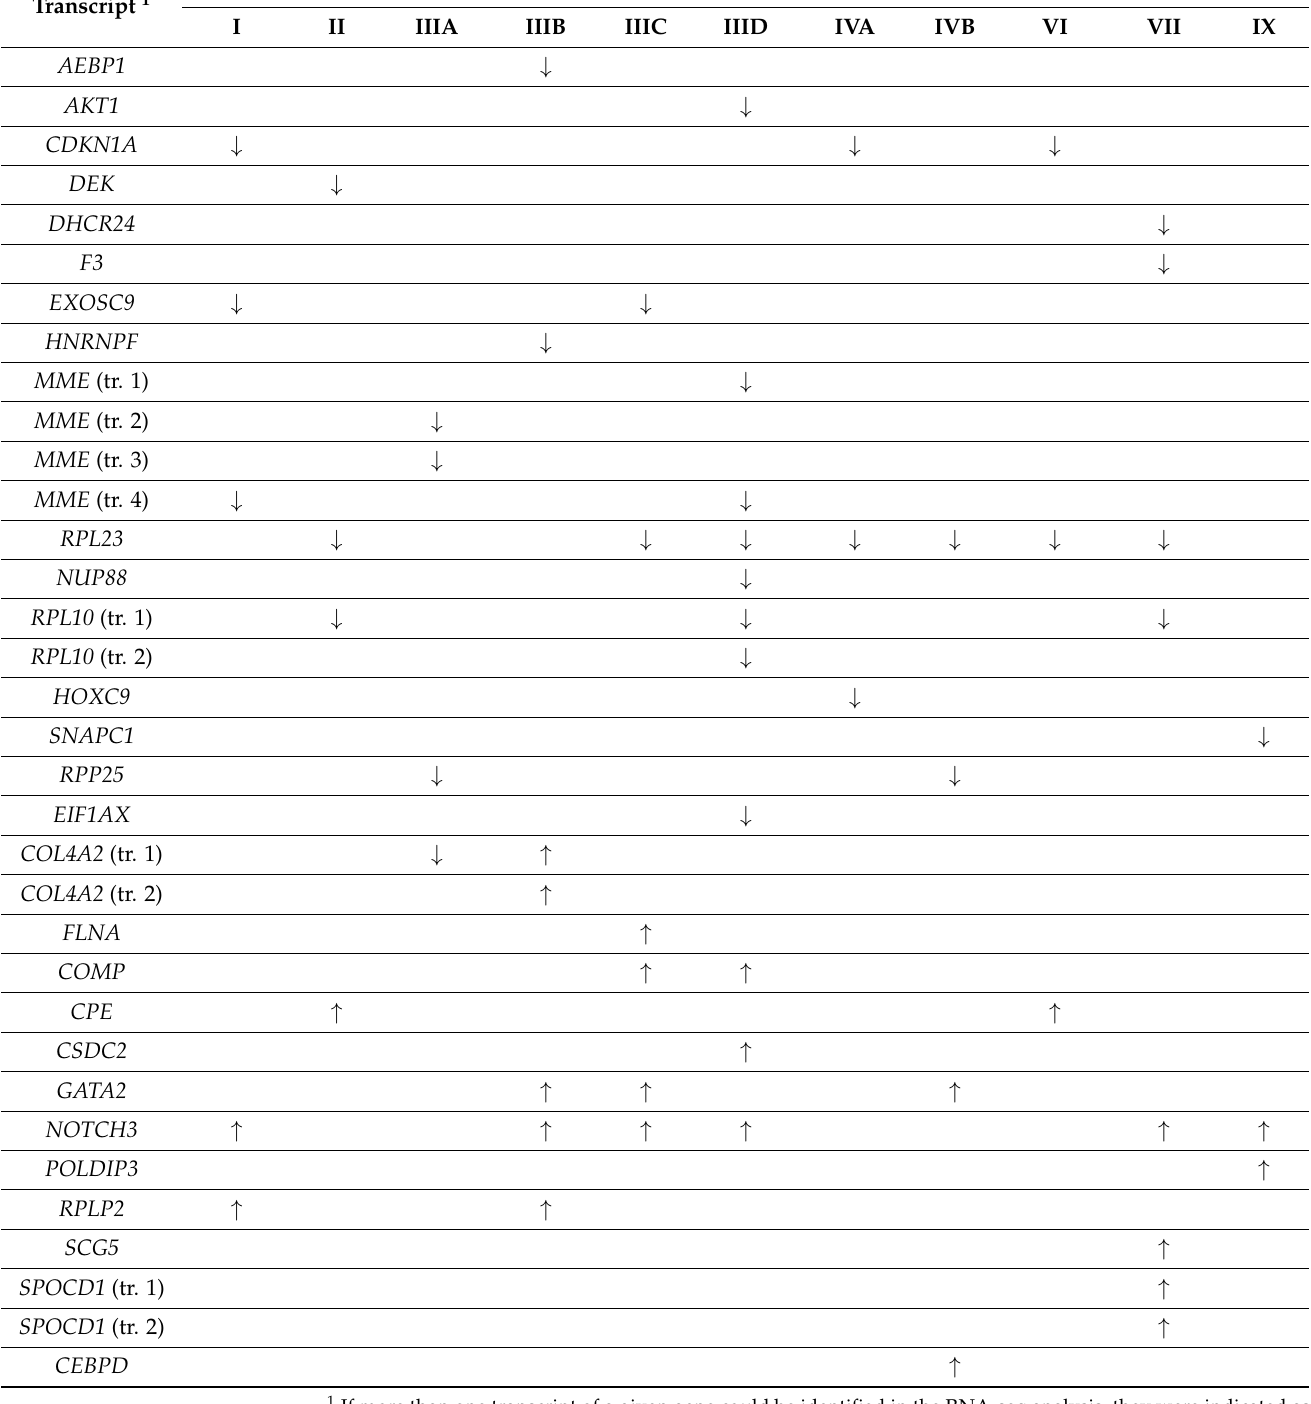
Table 1. Transcripts in which log 2 FC exceeded 2.0 in any MPS type vs. control cell